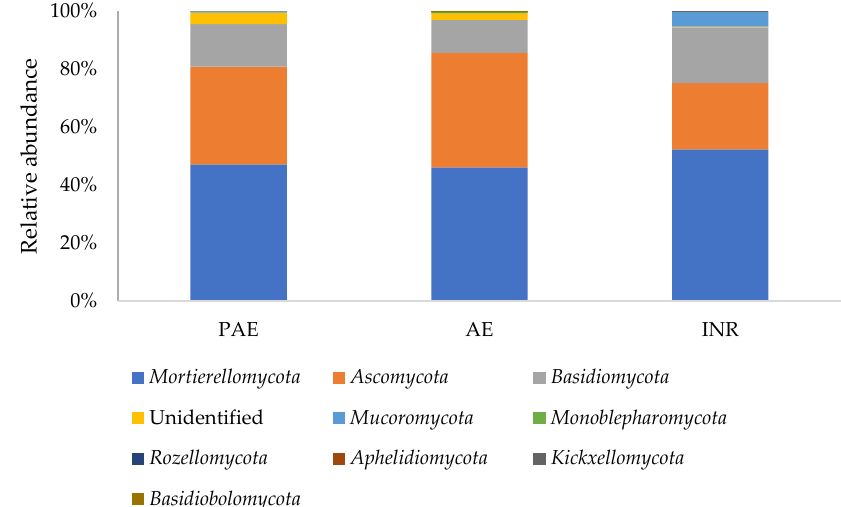
Figure 3. Average soil fungal relative abundances at phylum level of soil samples taken from the Polluted AgroEcosystem (PAE), the AgroEcosystem (AE), and the integral natural reserve (INR).